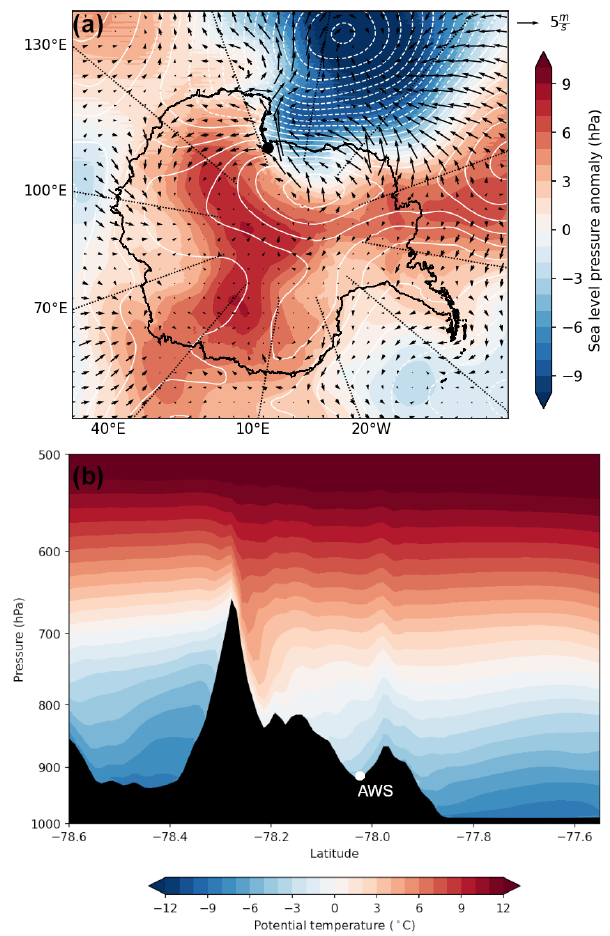
Figure 5. (a) Foehn anomaly of AMPS sea level pressure (shading), 500hPa geopotential height (contour) and 10m wind arrows for the 15km grid d02 domain. The foehn anomaly is calculated as the mean of the AMPS fields during foehn hours at Joyce Glacier mi- nus the mean during hours without foehn. (b) Composite of AMPS potential temperature profile during foehn events at Joyce Glacier over the transect shown in Fig.